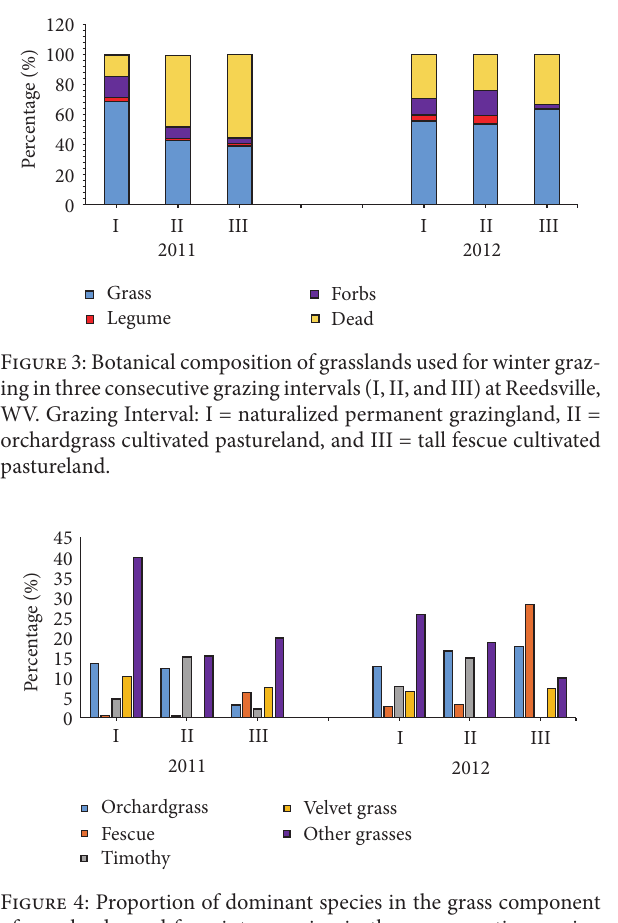
Figure 4: Proportion of dominant species in the grass component of grasslands used for winter grazing in three consecutive grazing intervals (I, II, and III) at Reedsville, WV. Grazing Interval: I = naturalized permanent grazingland, II = orchardgrass cultivated pastureland, and III = tall fescue cultivated pastureland.